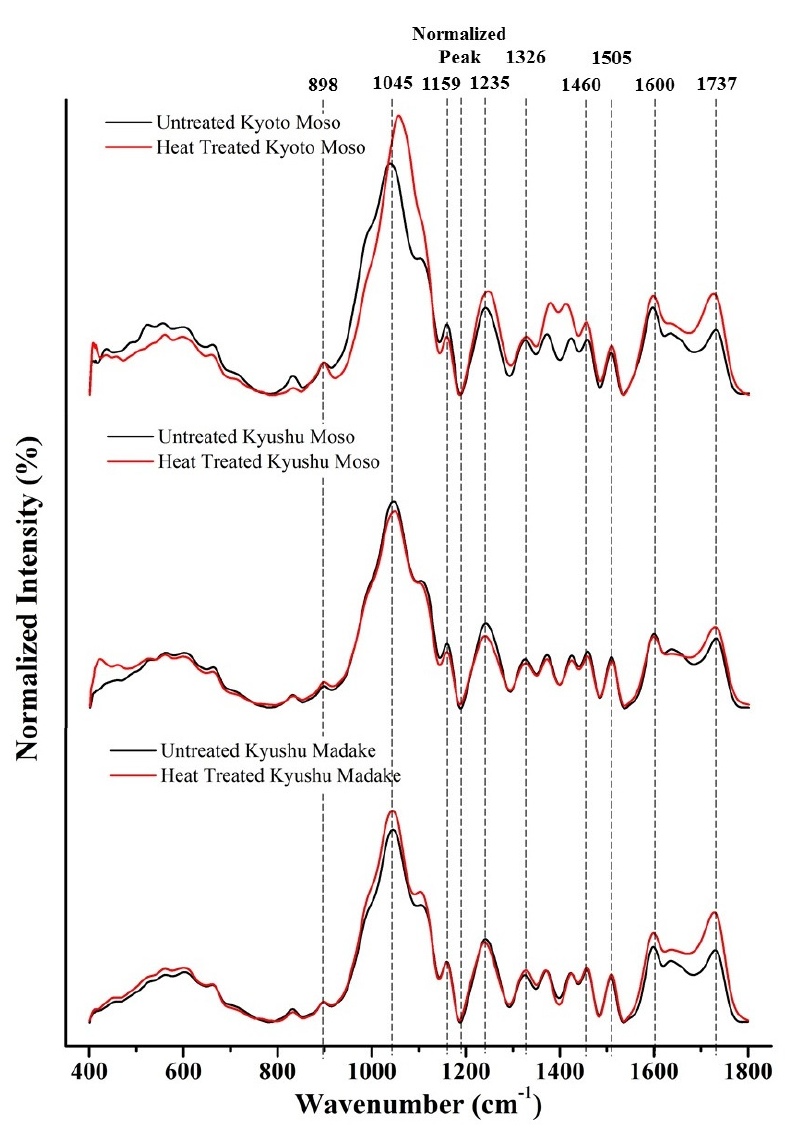
Figure 7. FTIR spectra in the range 400–1800 cm − 1 of three different types of untreated and thermally modified bamboo specimens, namely, Kyoto Moso, Kyushu Moso and Kyushu Madake bamboo. Table 3. Characteristic bands of FTIR spectra of various bamboo specimens in the frequency interval 400 to 1800 cm − 1 .